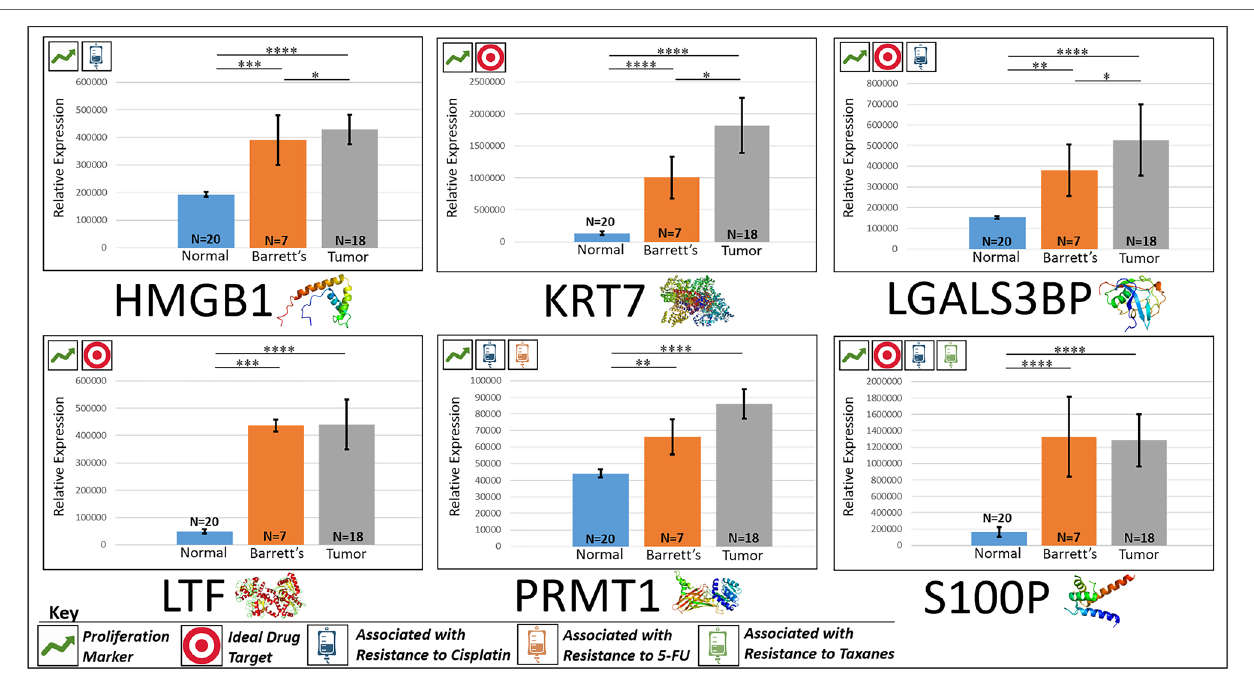
FIGURE 2 | Upregulated proliferation markers. These six markers are associated with more advanced progression in various cancers and were found to be upregulated or overexpressed in our cohort’s esophageal adenocarcinoma tumor tissue compared to normal squamous esophageal epithelium, possibly contributing to enhanced invasiveness and shorter overall survival. **** P < 0.0001, *** P < 0.001, ** P < 0.01, * P <